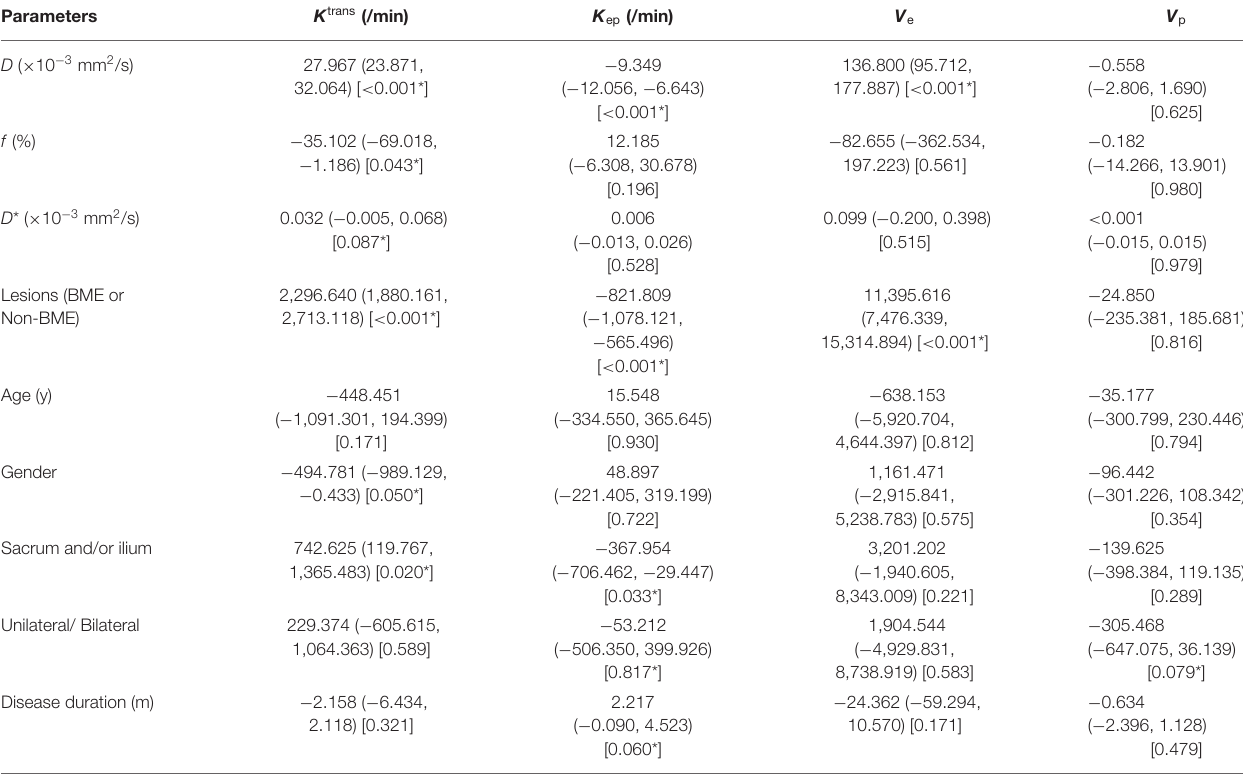
TABLE 4 | Results of univariable lines regression analyses. Parameters